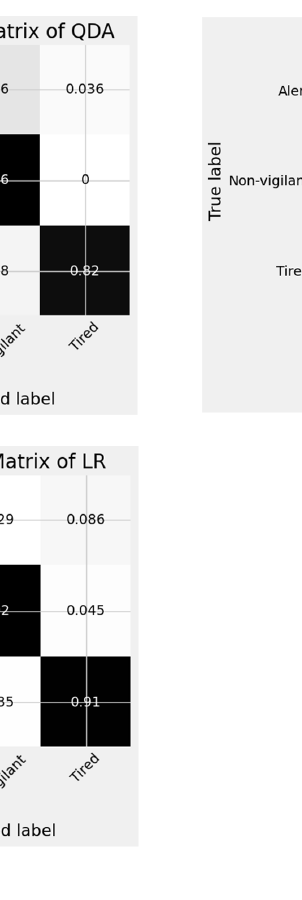
Figure 11. Confusion Matrix of The Proposed Machine Learning Models for Multi-c lass Scenarion